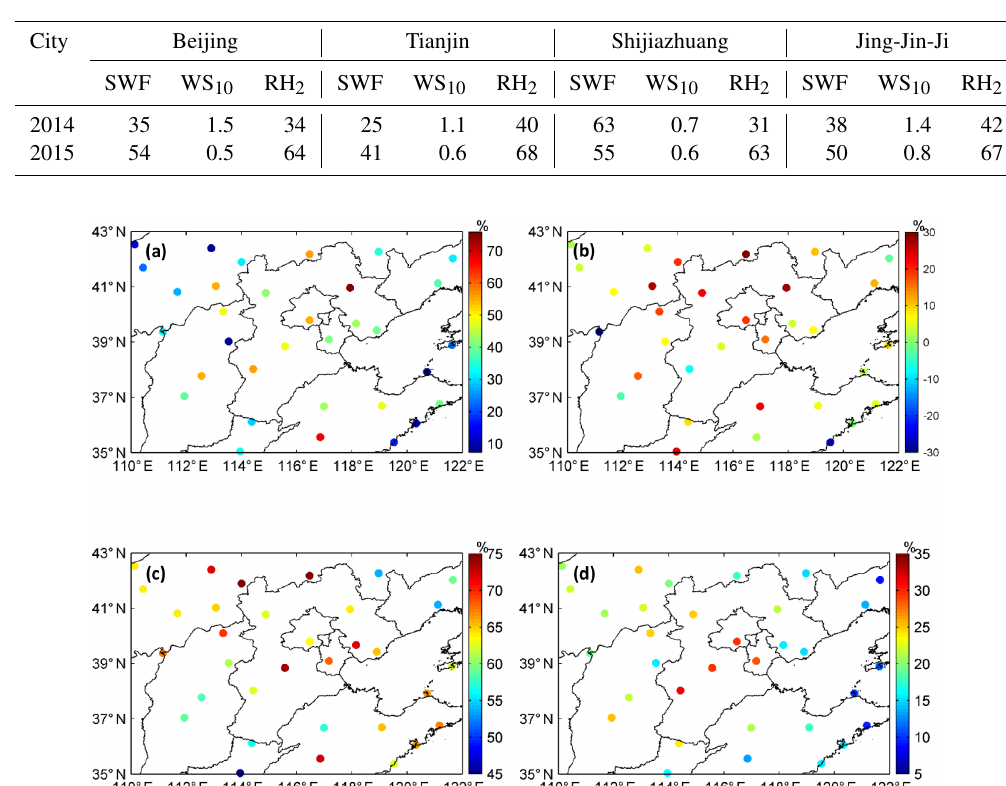
Figure 6. The observed SWF and RH 2 distribution average for December 2015 (a, c) ; Changes from 2014 (b, d)